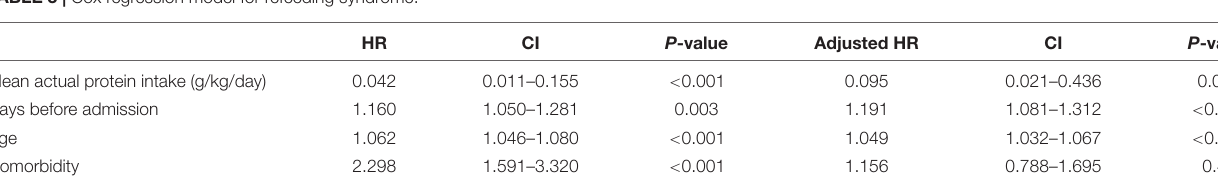
TABLE 3 | Cox regression model for refeeding